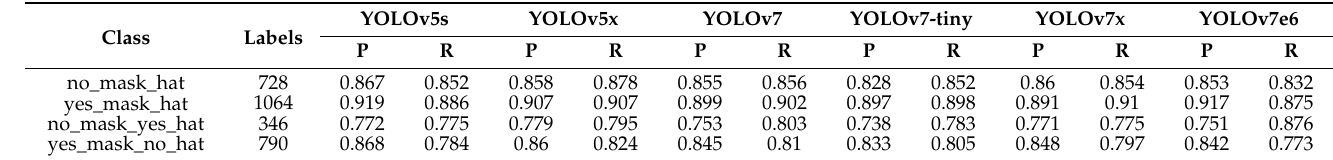
Table 5. The precision (P) and recall (R) of the four conditions for chefs’